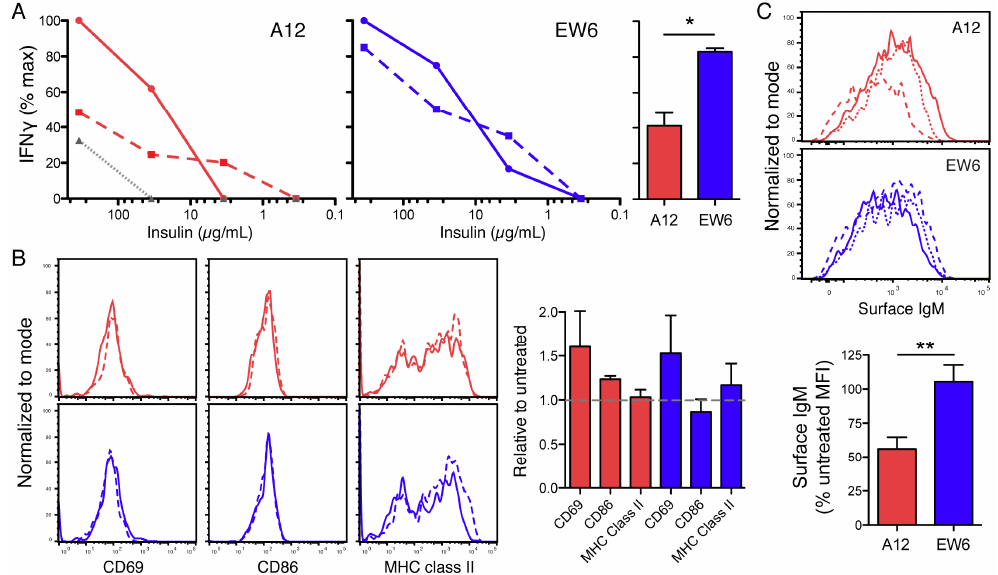
Figure 5. B cell tolerance affects ability to present antigen to T cells. ( A ) IFN γ secretion by PD12 ‐ 4.4 T cell clones co ‐ cultured with TR ‐ B cells and indicated concentrations of insulin (solid lines)